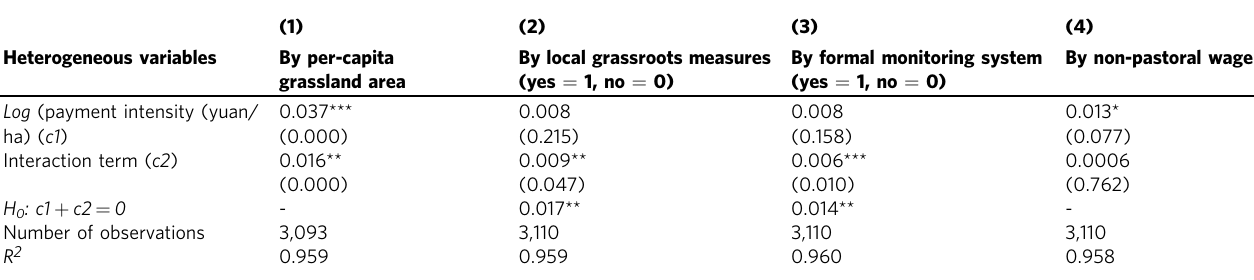
Table 7 Estimated heterogeneous impacts of the Grassland Ecological Compensation Program (GECP) on grassland quality: household